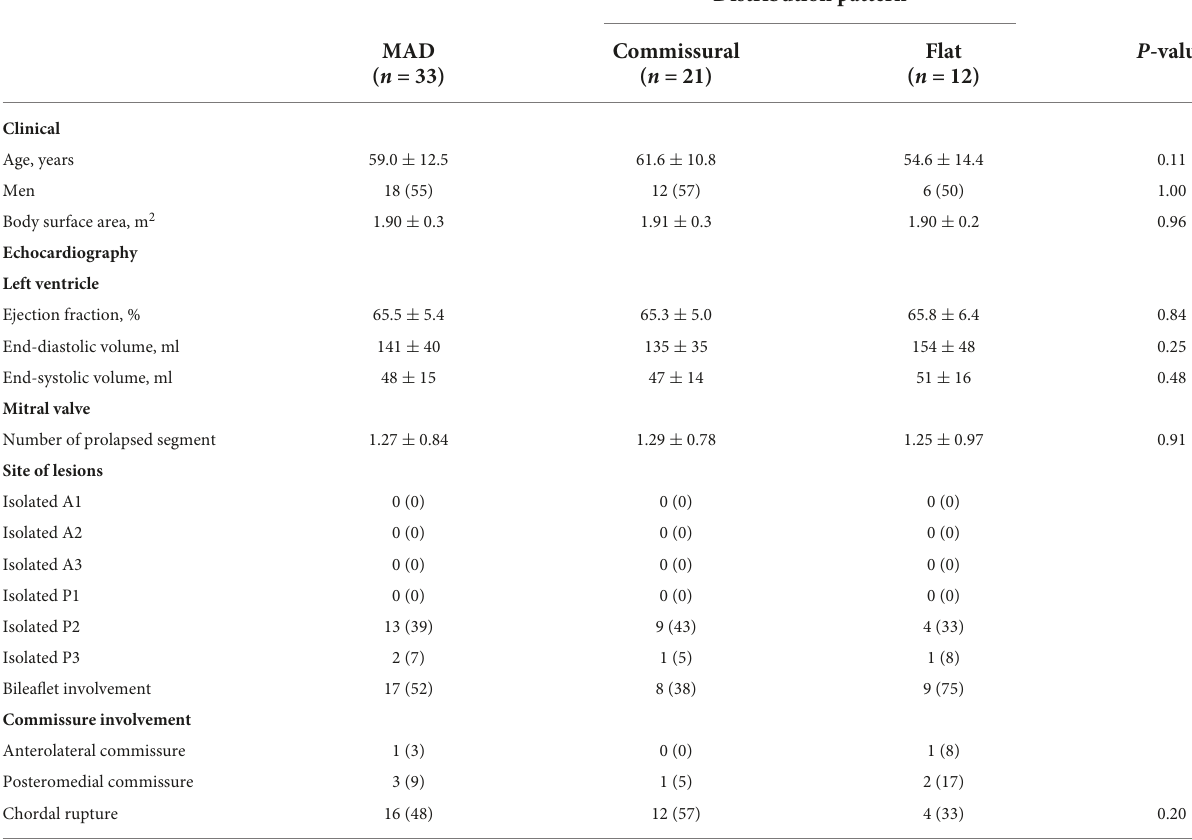
TABLE 1 Patient